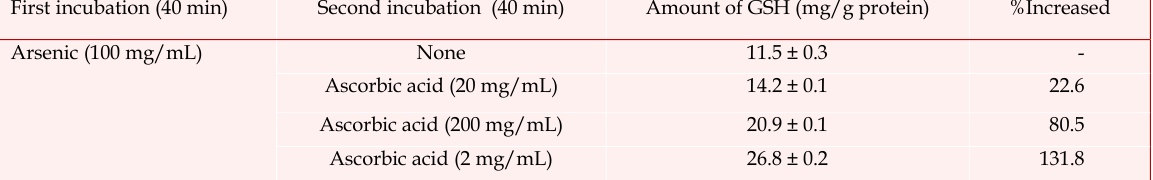
Effect of different concentrations of ascorbic acid on GSH level in arsenic loaded liver tissues